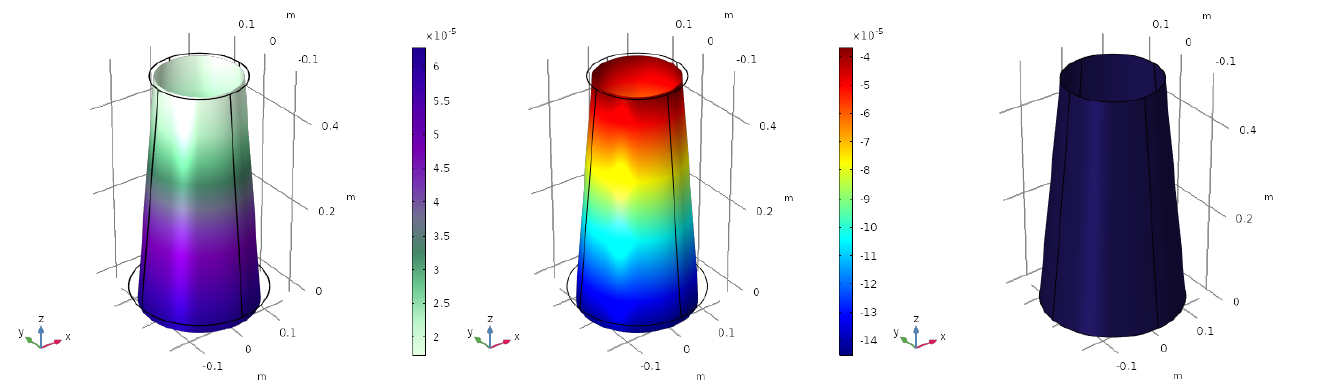
Figure 1. Pressure uniformly distributed. Deformation of the structure ( left ), electric charge ( centre ) and optimized electrode profile ( right ).